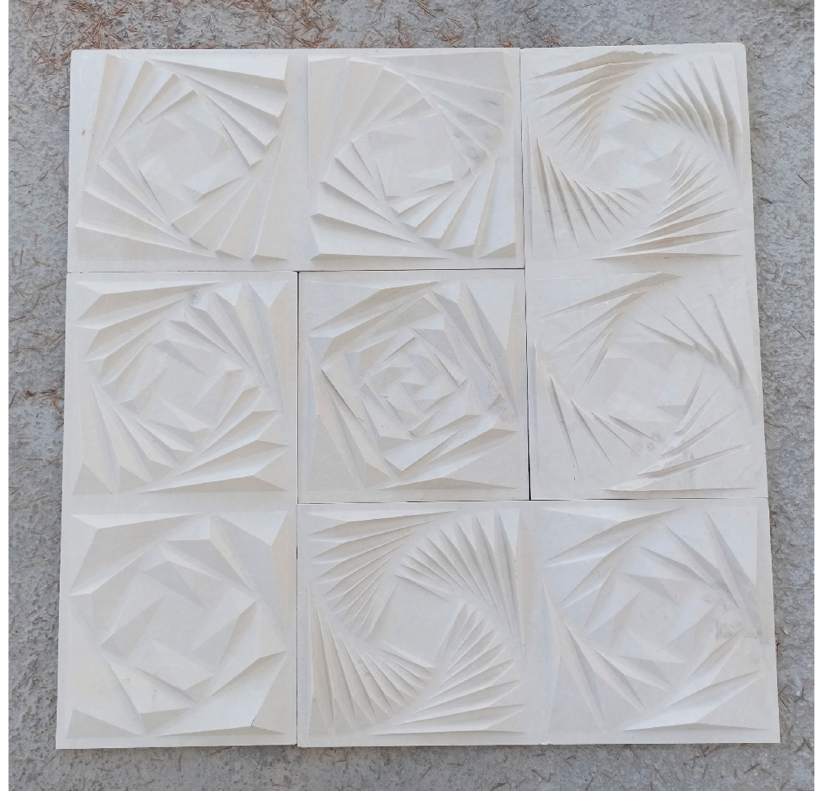
Figure 18. The result, generated with proposed method by applying different transformation rules defined with corner-weight , median-weight , height , and rotation parameters at each iteration ( center ) and the results generated by applying same transformation rules at each iteration ( others ).